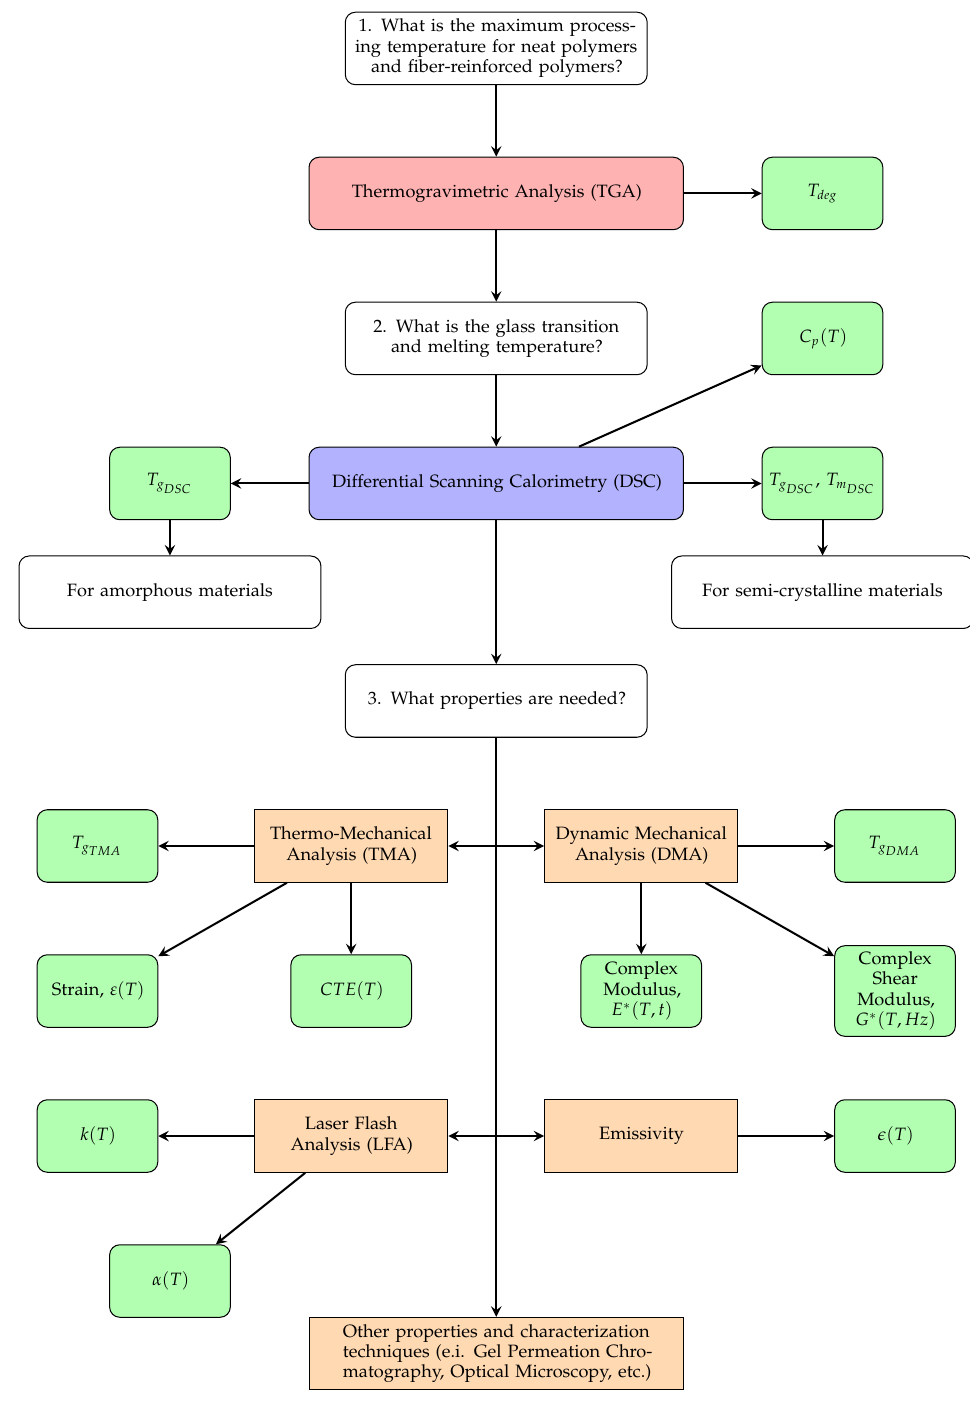
Figure 3. Proposed roadmap for material characterization. Note that a new sample should be used for each characterization method and for each repetition. Labels in color red, blue, and orange represent characterization techniques. Labels in color green are material properties acquired from each characterization technique.